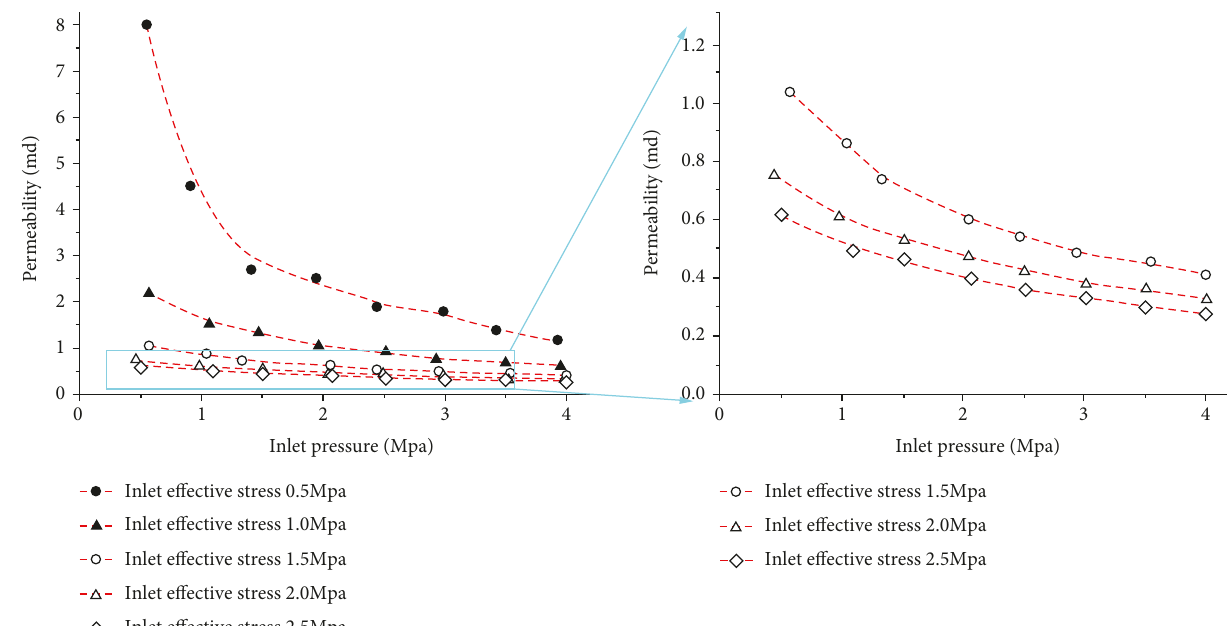
Figure 10: Test results on the pore pressure seepage under constant inlet e ff ective stresses.